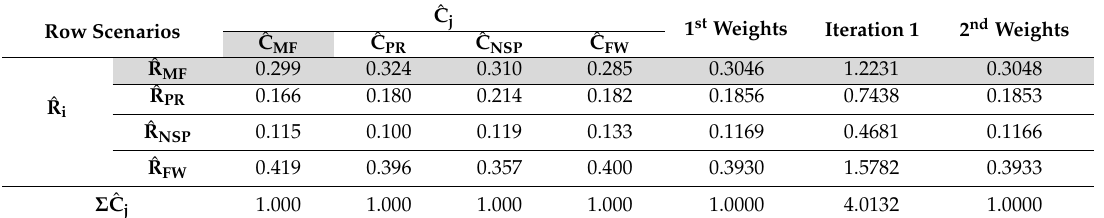
Table 9. Example normalised matrix of pairwise comparisons of CE scenarios for indicator 1.